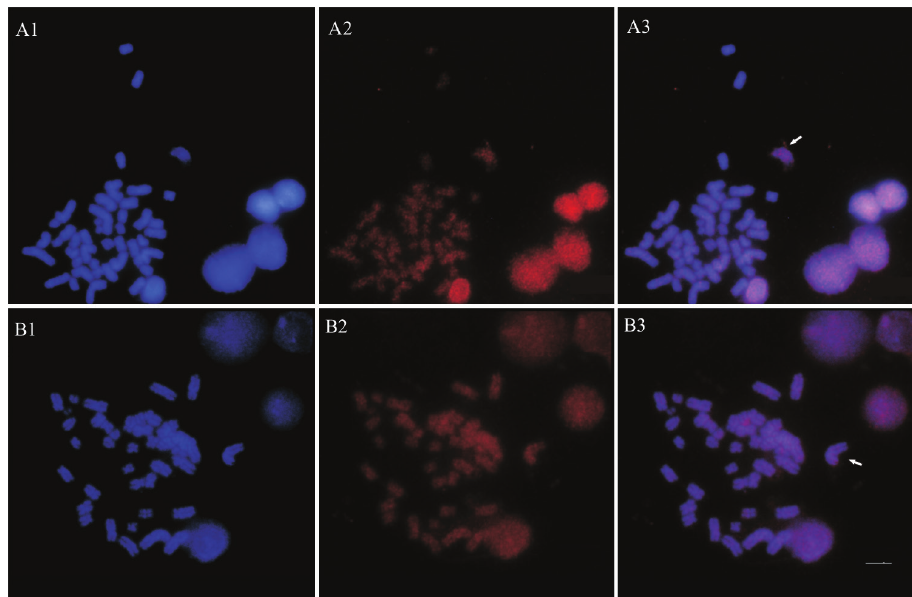
Figure 4. In situ fluorescence hybridization using AnDraI as probe in Ancistrus sp.1 “Flecha”: A female B male. The arrows show some examples of pericentromeric and spread signals. Bar = 10